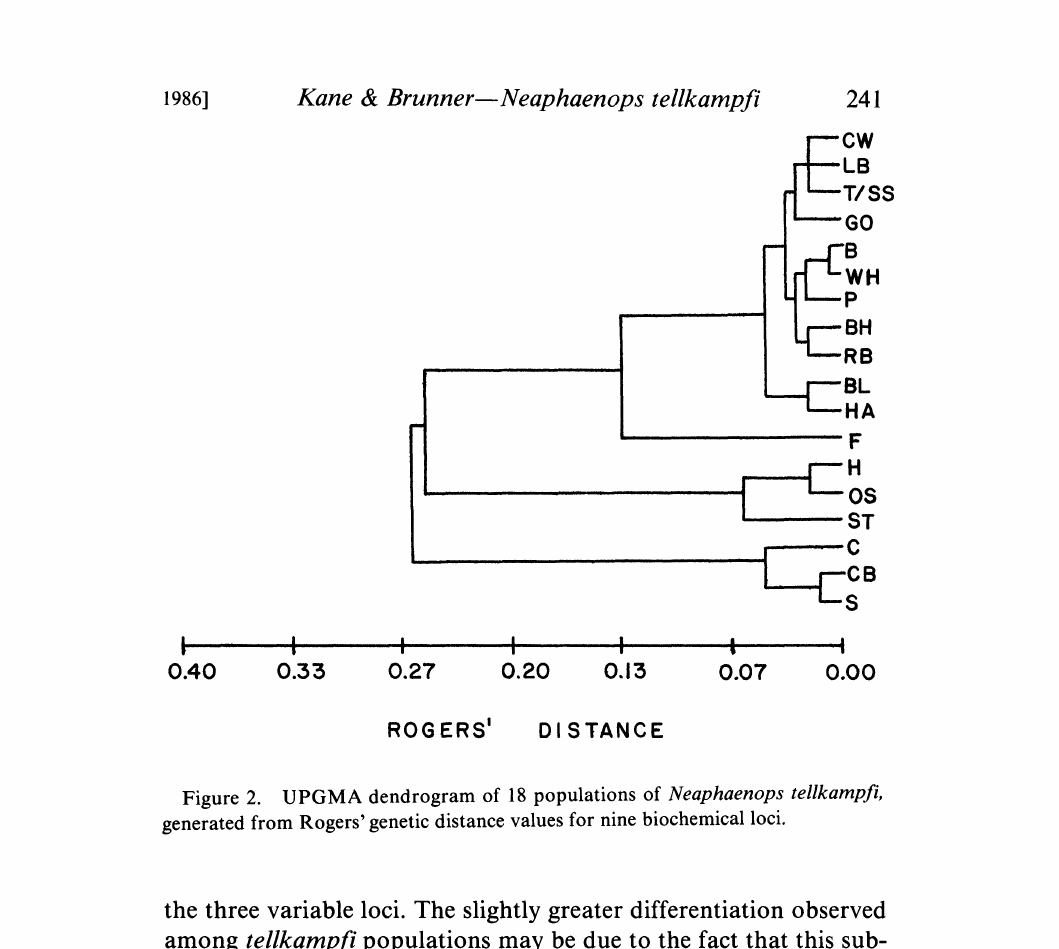
Figure 2. UPGMA dendrogram of 18 populations of Neaphaenops tellkampfi, generated from Rogers’ genetic distance values for nine biochemical